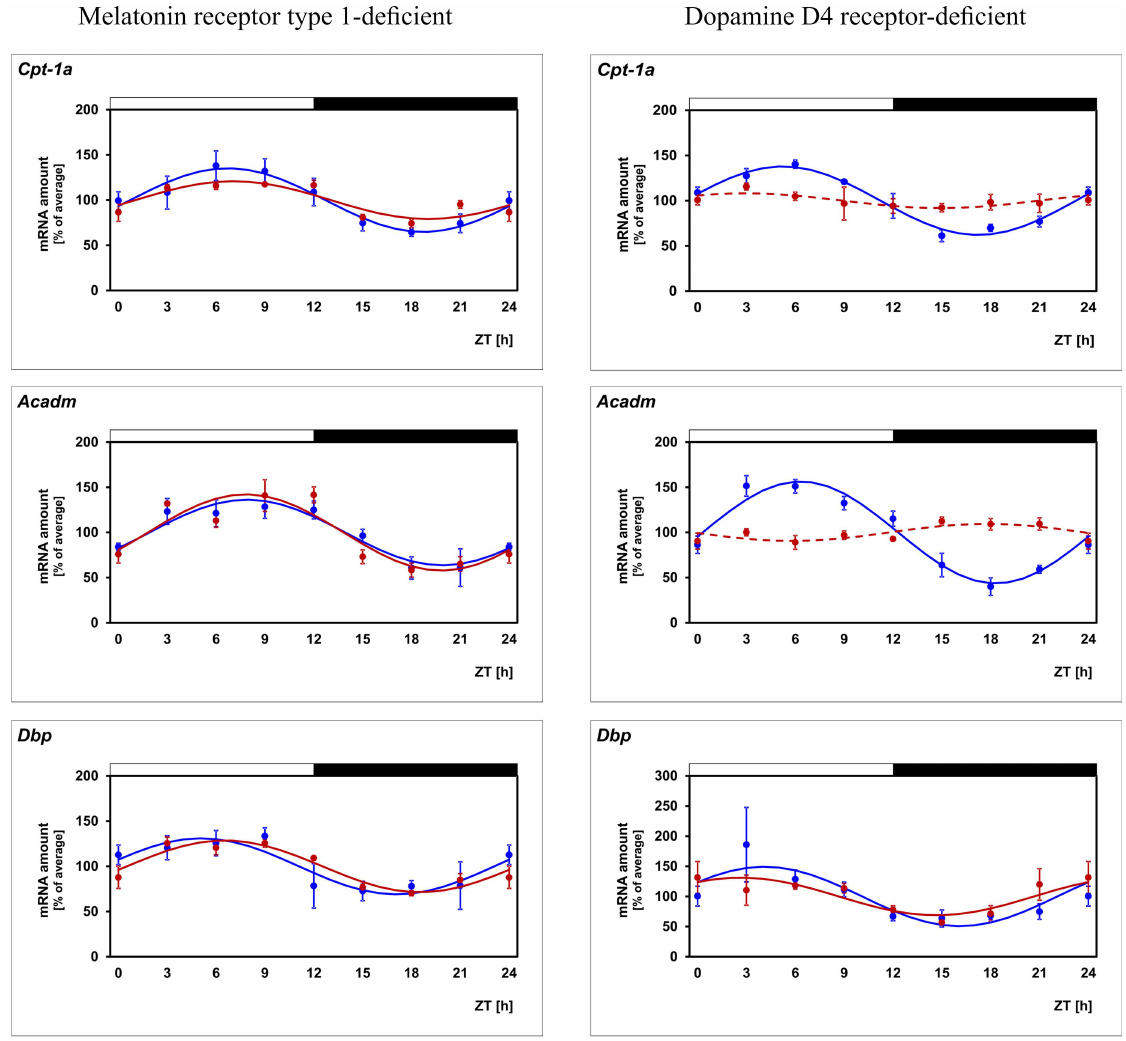
Fig 3. Daily profiling of enzymes of the FAO pathway in mice deficient for either melatonin receptor type 1 or dopamine D4 receptor. Transcript levels of Cpt-1 α , Acadm and Dbp are recorded in WT mice (blue lines) and in mice deficient for either melatoninreceptor type 1 (left column, red lines) or dopamineD4 receptor (right column, red lines) in preparationsof the whole retina under light/dark (LD) 12:12 determinedby using qPCR. The mRNA levels are plotted as a function of Zeitgeber time (ZT). The lines represent the periodicsinusoidalfunctions determined by cosinor analysis(solid and broken line for p < 0.05 and p > 0.05). Data represent a percentageof the average value of the transcript amount during the 24-h period. Statistical analysisof transcriptional profiling is provided in Table 3. The value of ZT0 was plotted twice at both ZT0 and ZT24. The solid bars indicate the dark period. Each value represents mean ± SEM (n = 4; each n represents two animals / four retinae). Note that periodicity of Cpt-1 α and Acadm , but not that of the reference gene Dbp , is depressedin mice deficient for dopamineD4